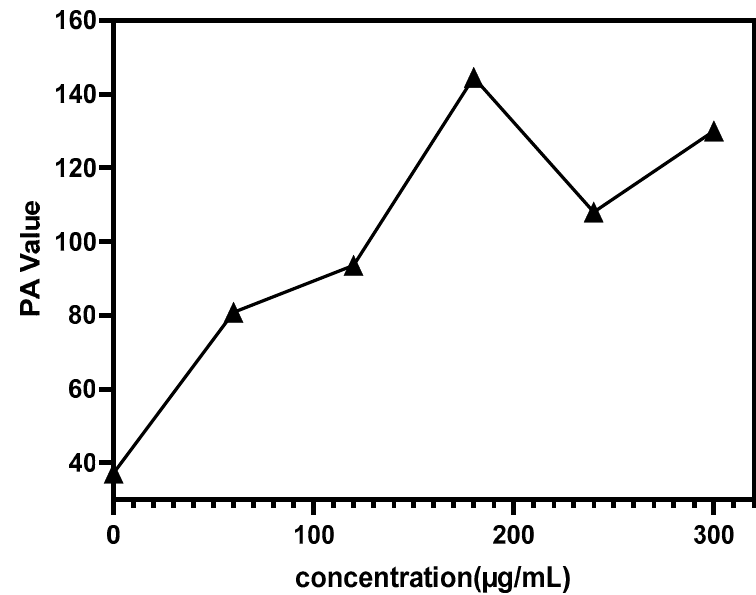
Figure 9. PA Value of different concentrations of Au-UCNPs-DSPE-PEG 2K.